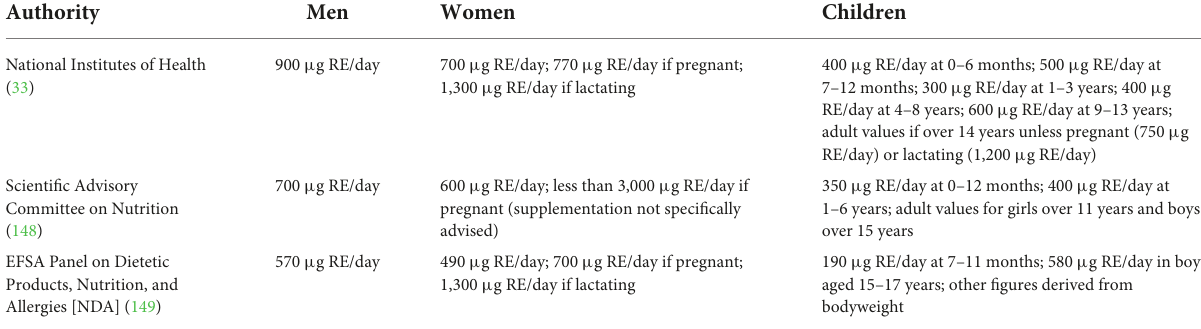
TABLE 1 Summary of dietary advice regarding daily vitamin A intake from the United States of America (National Institutes of Health Office of Dietary Supplements, NIH ODS), United Kingdom (Scientific Advisory Committee on Nutrition, SACN), and European Union (European Food Safety Authority Panel on Dietetic Products, Nutrition, and Allergies, EFSA NDA).